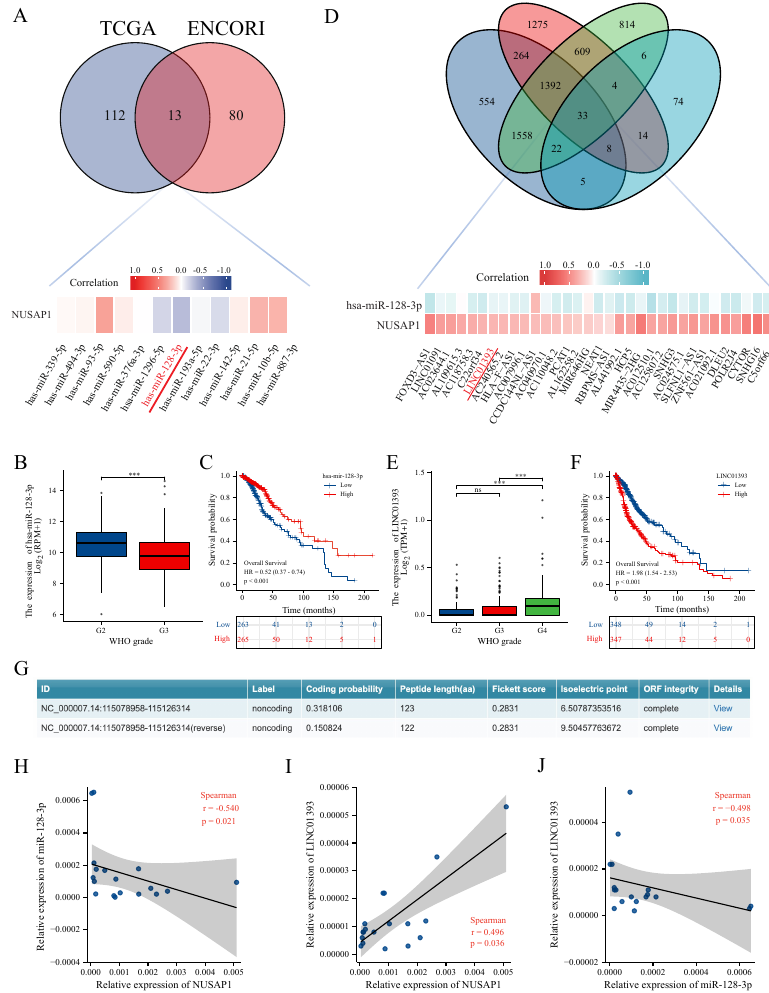
Figure 2. LINC01393 may regulate the expression of NUSAP1 by acting as a ceRNA of miR-128-3p in glioma. ( A ) Thirteen candidate miRNAs are screened by TCGA LGG-GBM cohort and EN- CORI database, and correlation between candidate miRNAs and NUSAP1 is displayed as heatmap. ( B , C ) Downregulated miR-128-3p correlated with higher tumor grade and poor prognosis of glioma from TCGA. ( D ) Thirty-three candidate lncRNAs are screened by TCGA LGG-GBM cohort and ENCORI database, and correlation among miR-128-3p, NUSAP1, and candidate lncRNAs are dis- played as heatmap. ( E , F ) High expression of LINC01393 correlated with higher tumor grade ( E ) and poor prognosis ( F ) of glioma from TCGA. ( G ) Protein coding ability prediction of LINC01393 by CPC 2.0. ( H – J ) qPCR correlation analysis among LINC01393, miR-128-3p, and NUSAP1 in human GBM samples. *** p < 0.001, ns: p >